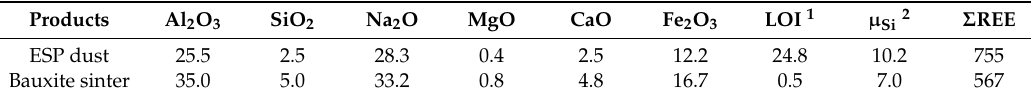
Table 1. The chemical composition of electrostatic precipitator (ESP) dust and bauxite sinter, wt. %. Products Al 2 O 3 SiO 2